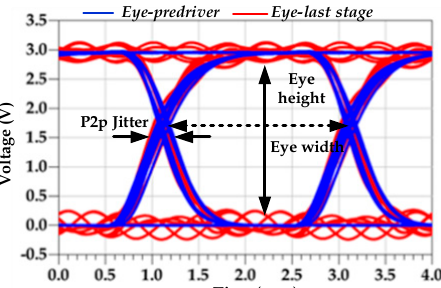
Figure 6. Eye diagram: pre-driver vs. last-stage PGSIJ at the SS − 40 °C corner.